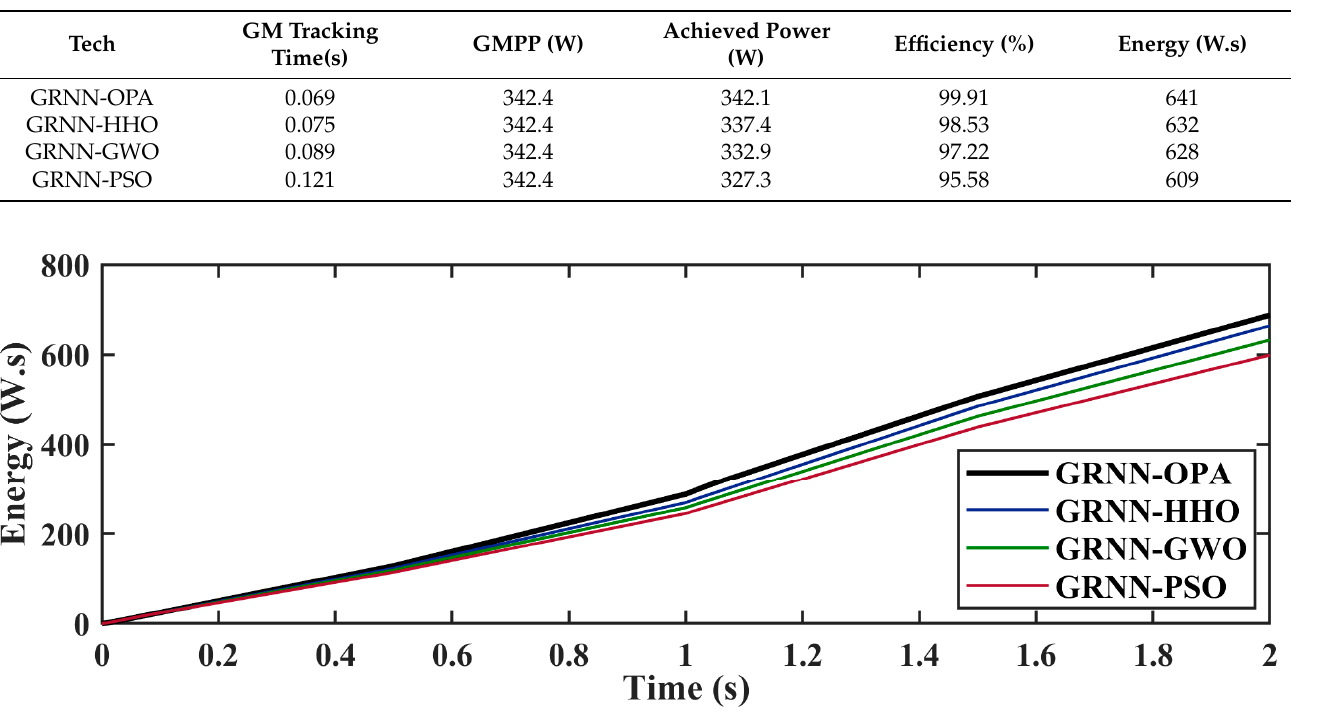
Figure 12. Comparison of energy extracted in case 3. Table 2. Comparison of results for case 2.